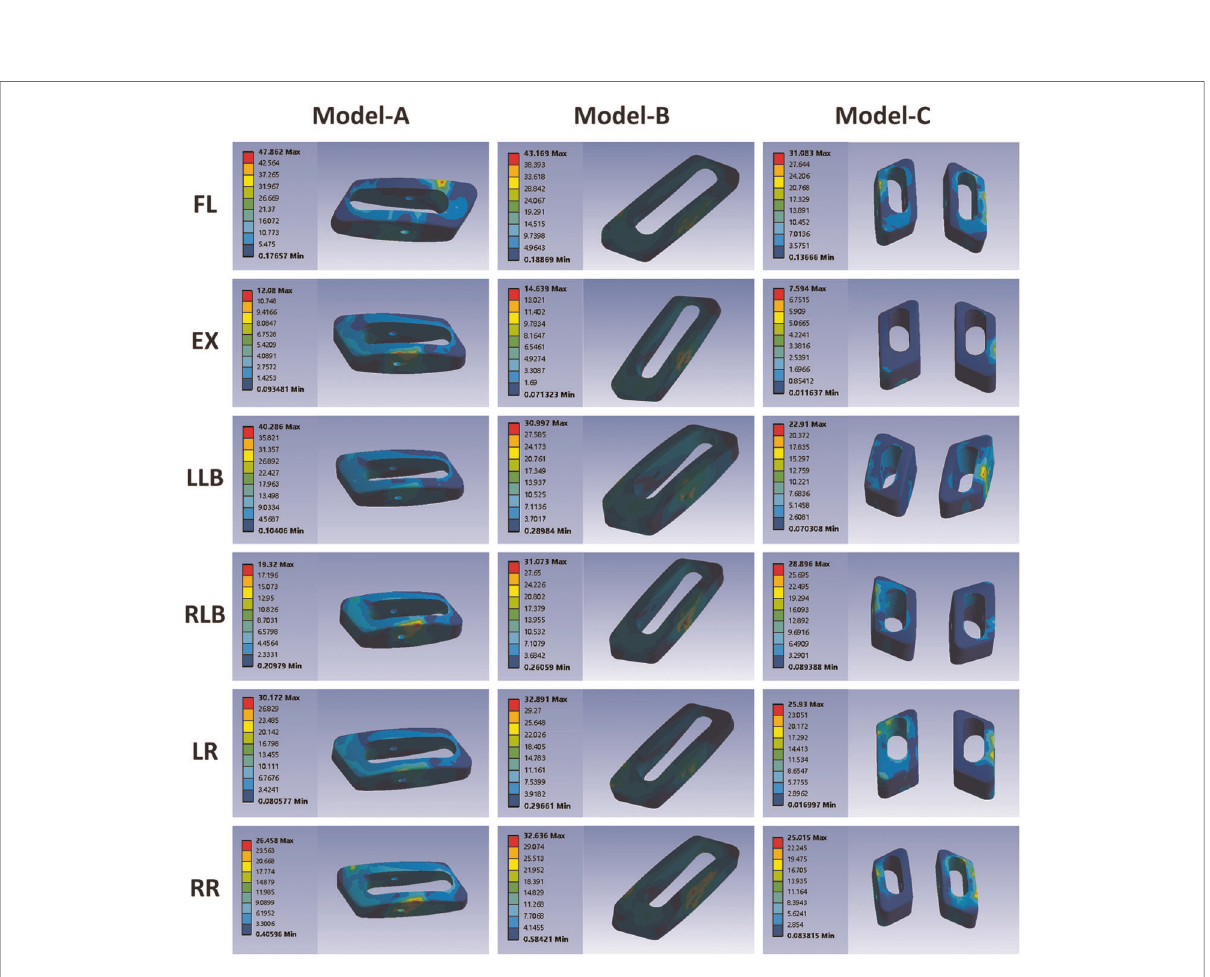
FIGURE 6 Stress cloud diagram of the